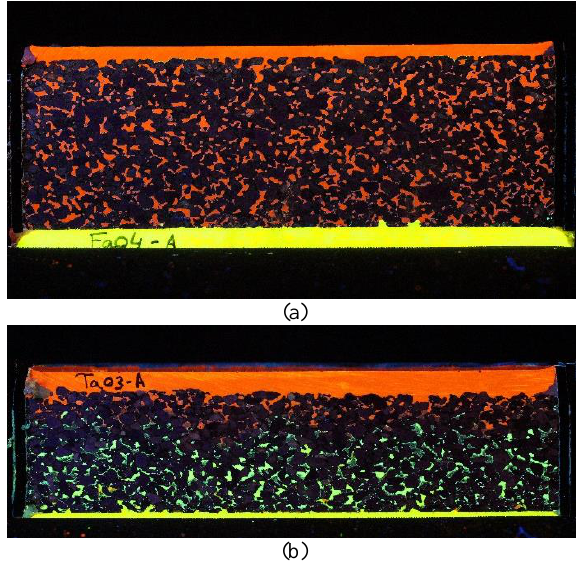
Figure 3: Images of 150 mm cores taken by the shooting device; (a): new surface course with no clogging; (b): older surface course with a clogging front at a depth of approximately 1cm